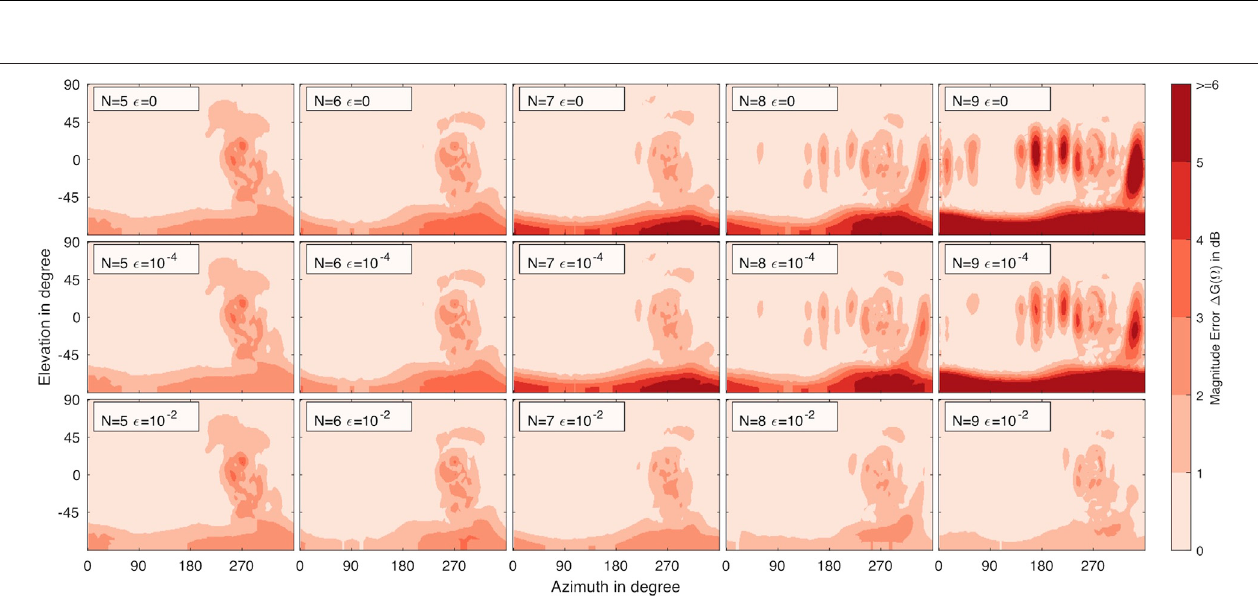
FIGURE 3 | Left-ear magnitude error Δ G ( Ω ) for grid Irregular 6 at selected SH orders and regularization values ϵ . HRTF: Subject no. 10 from HUTUBS database.